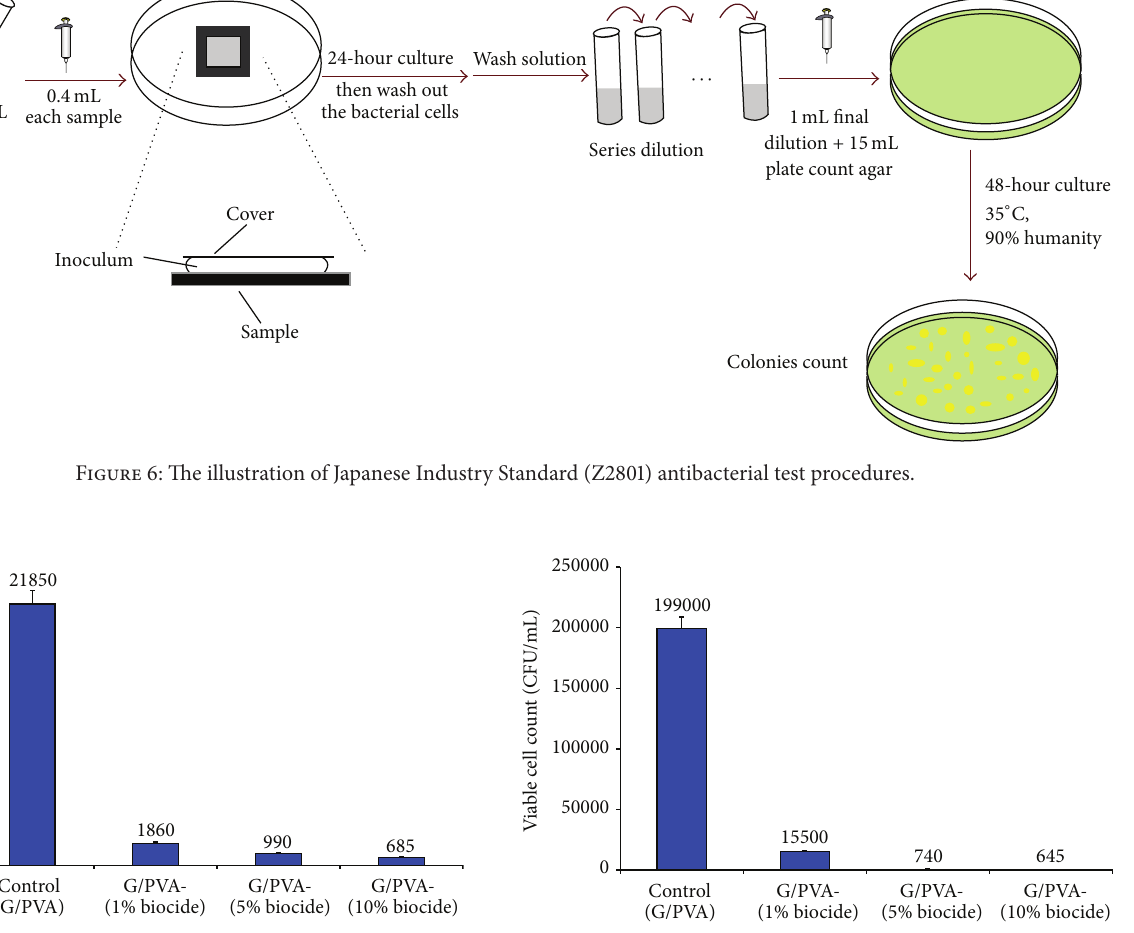
Figure 7: Antimicrobial test of the G/PVA-biocide antimicrobial nanocomposite films against E. coli after incubation at 37 ∘ C for 24 hours and the control test film was G/PVA.